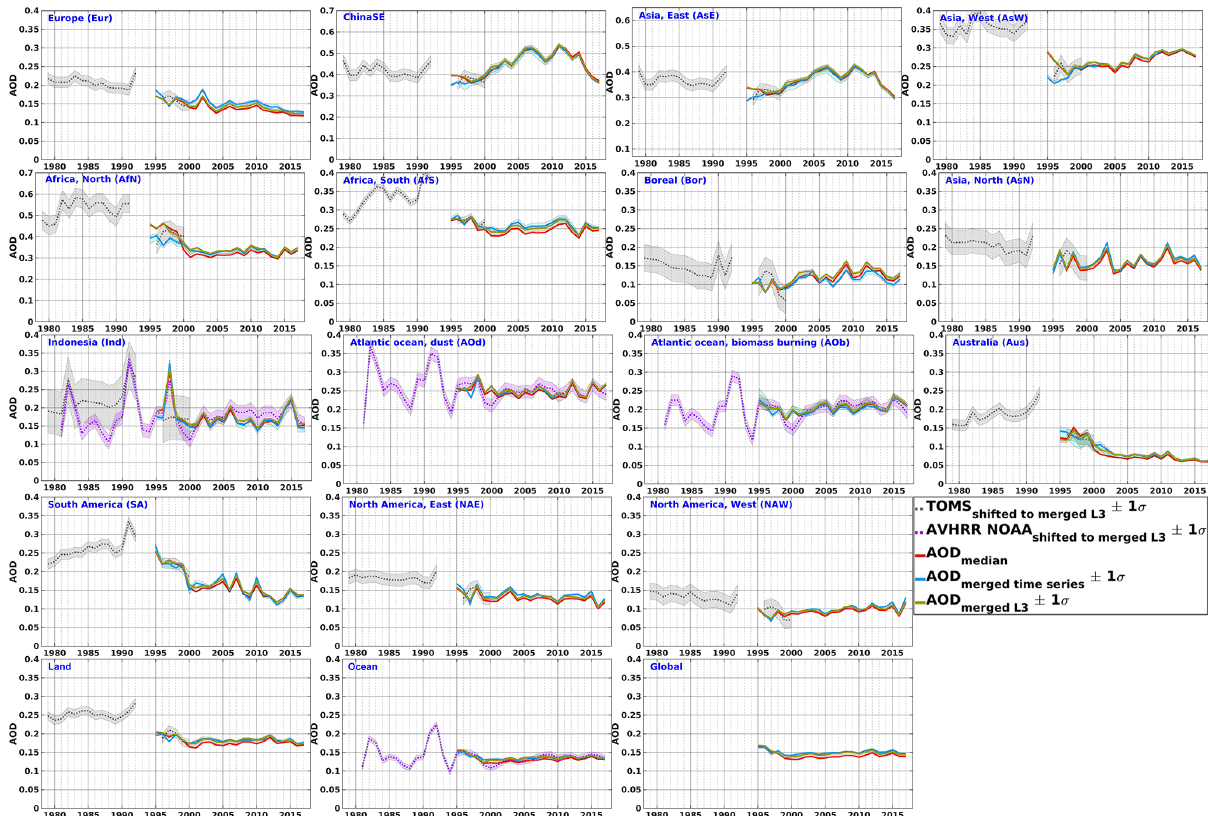
Figure 12. Annual AOD time series merged with two different approaches (red and light blue for approaches 1 and 2, respectively) and AOD time series from the L3 merged data (approach 2; olive) for the selected regions. In each, ± 1 σ of the AOD from all uncorrected AOD products is shown as light blue shadow (often small, thus not visible). TOMS over land and AVHRR NOAA over ocean products shifted to the merged time series are also shown with dashed grey and purple lines, respectively, when